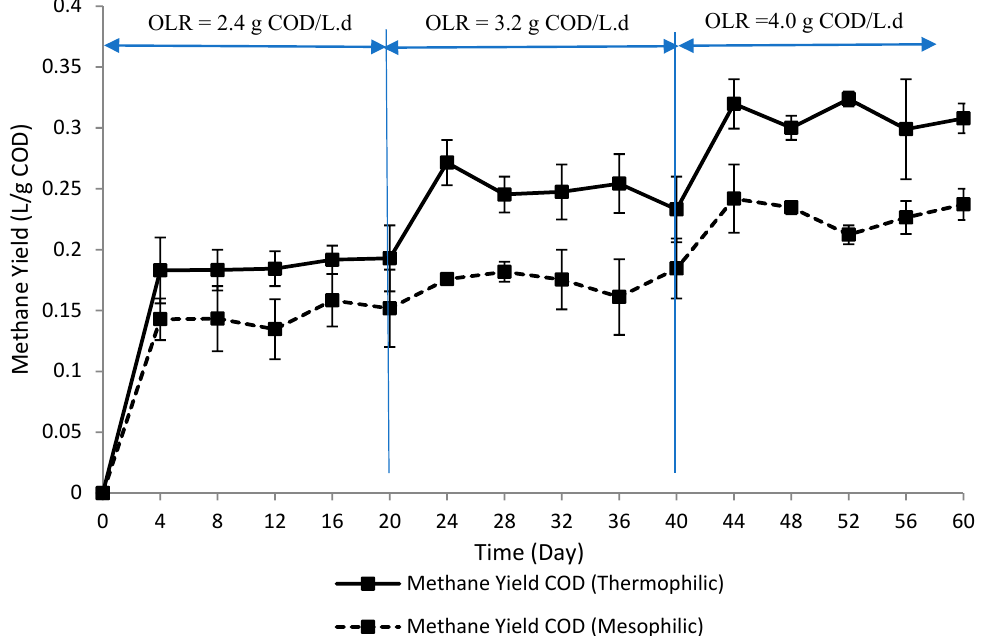
Figure 2. The methane yield at various organic loading rates (OLRs). Notes: error bars show standard deviation of means (n = 3).